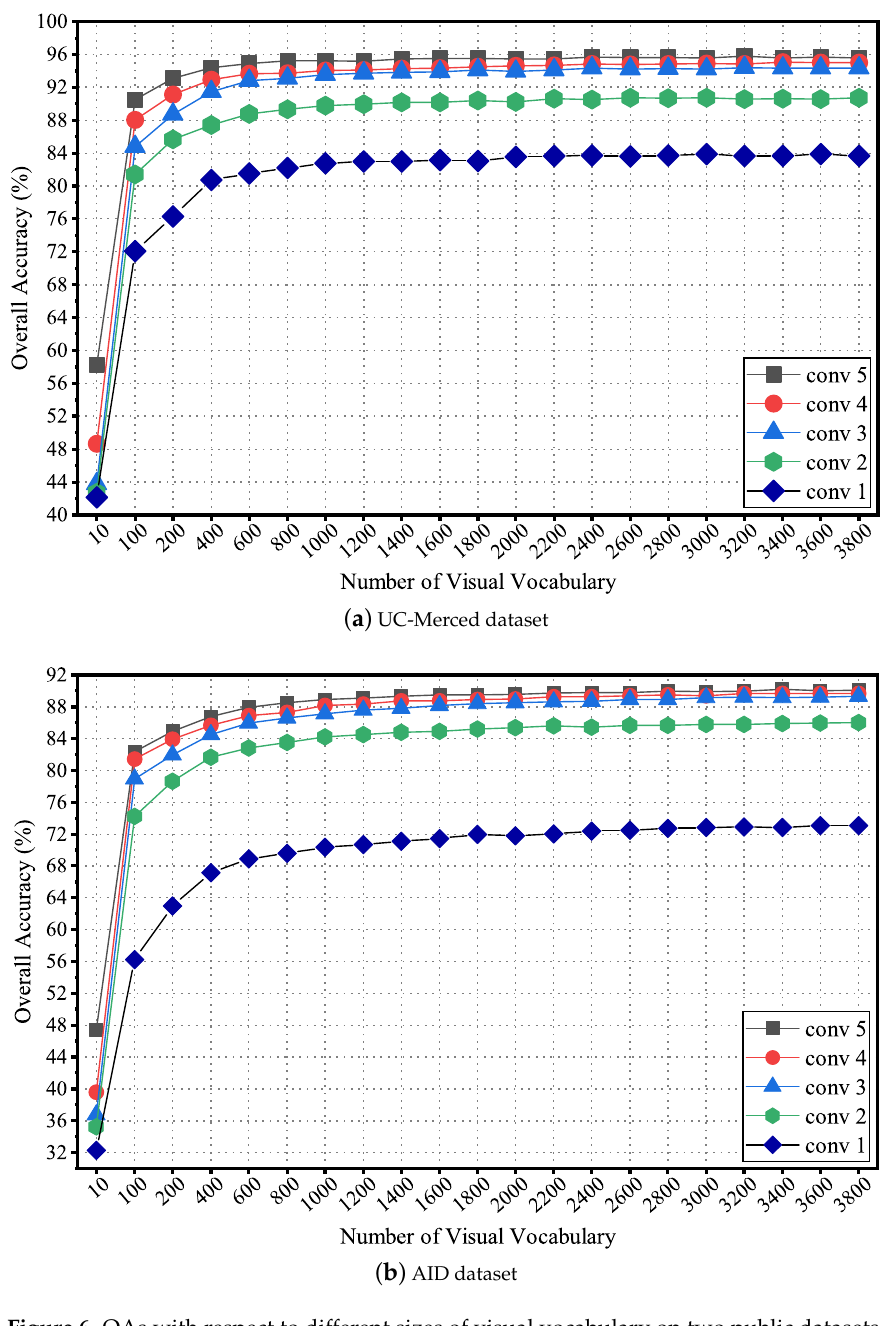
Figure 6. OAs with respect to different sizes of visual vocabulary on two public